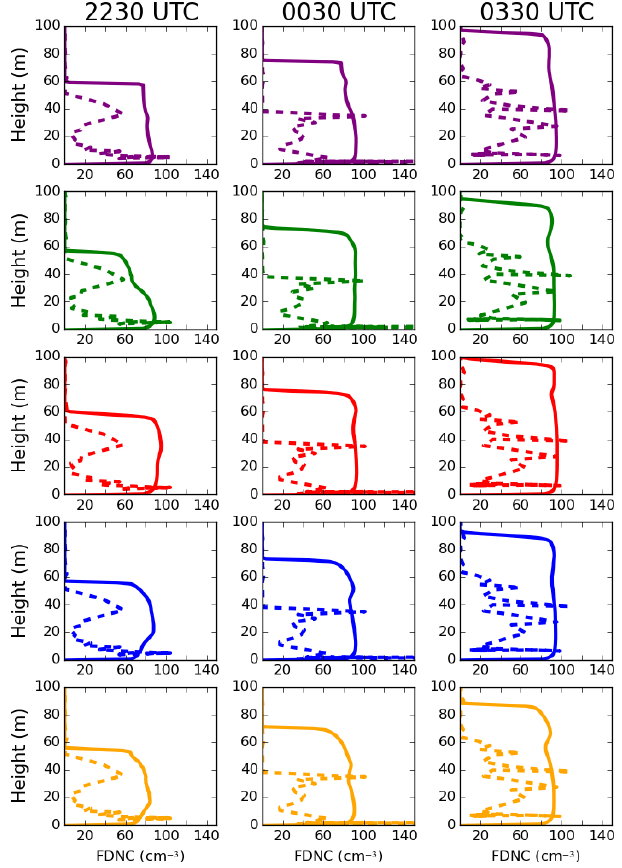
Figure 4. Vertical profiles of the fog droplet number concentration (cm − 3 ) at 22:30, 00:30 and 03:30UTC. The dashed lines represent observations, and solid lines represent simulated values. Purple –